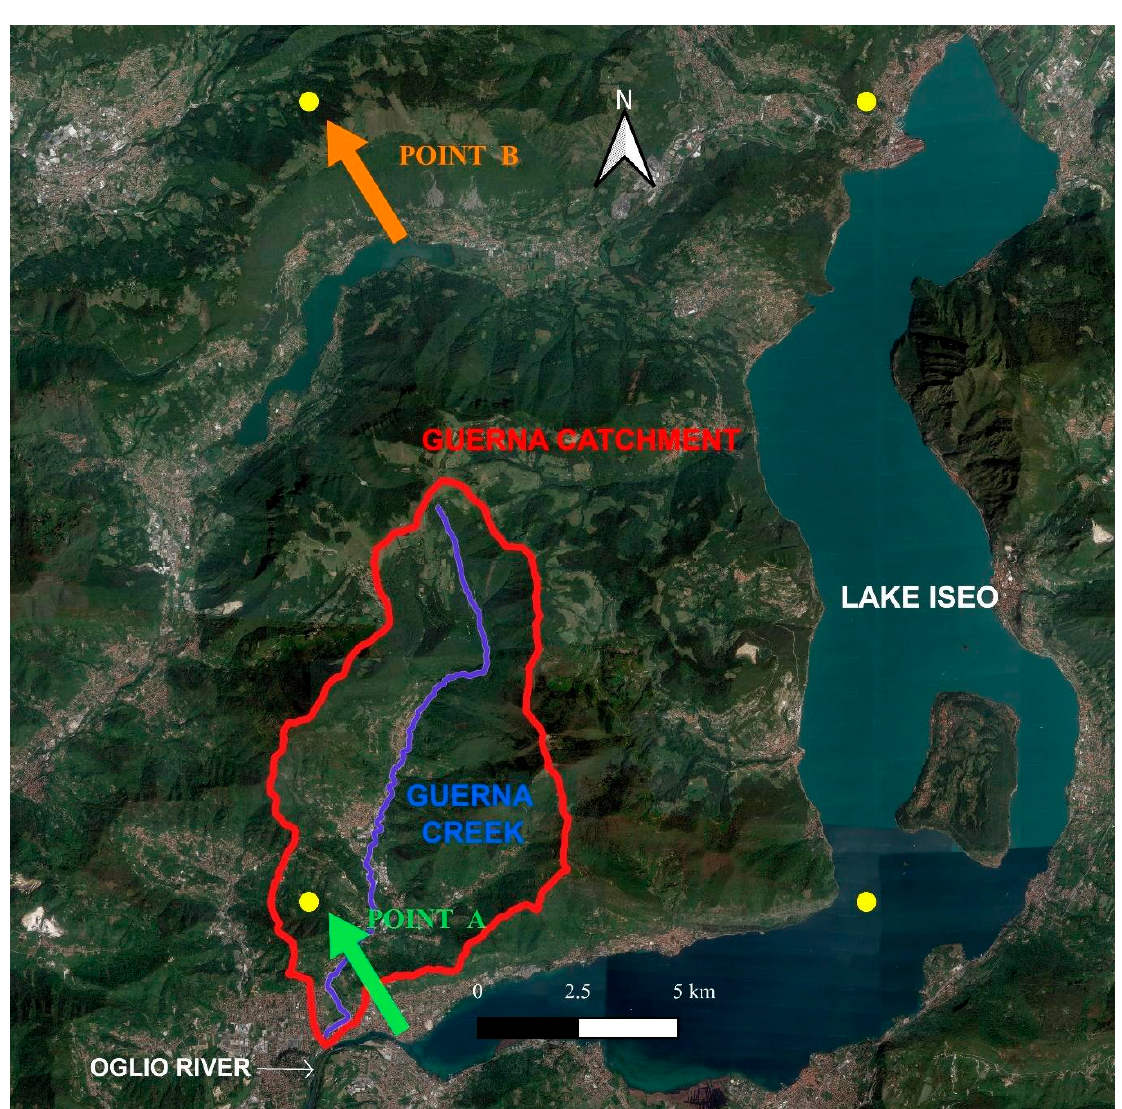
Figure 3. Regional Climate Model (RCM) grid points over the case study area.